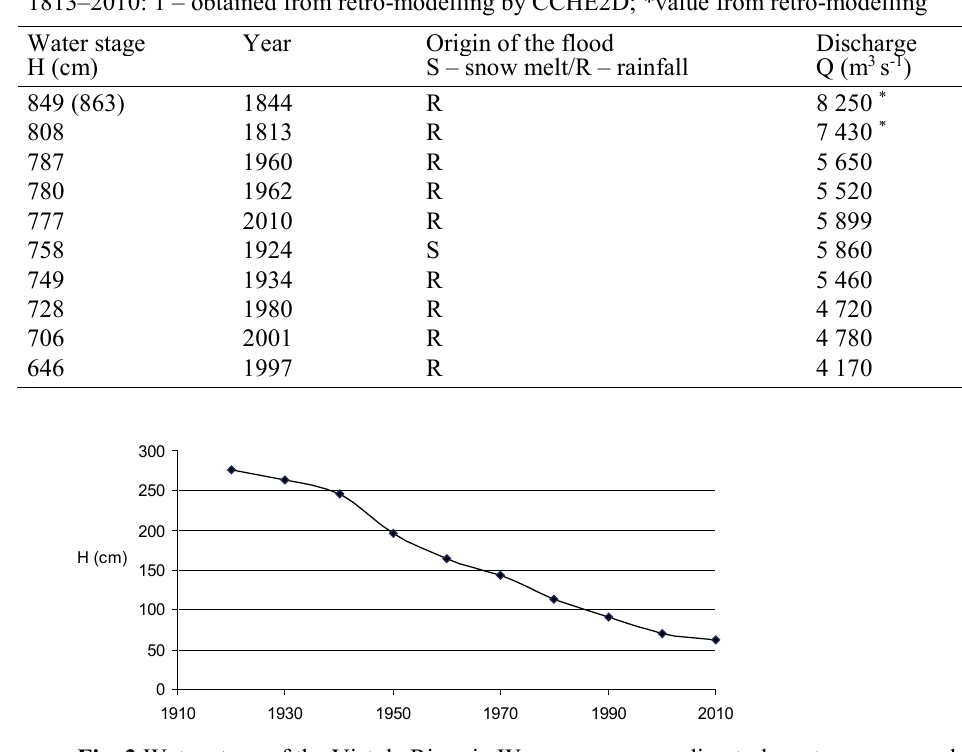
Fig. 3 Water stage of the Vistula River in Warsaw corresponding to long-term average low